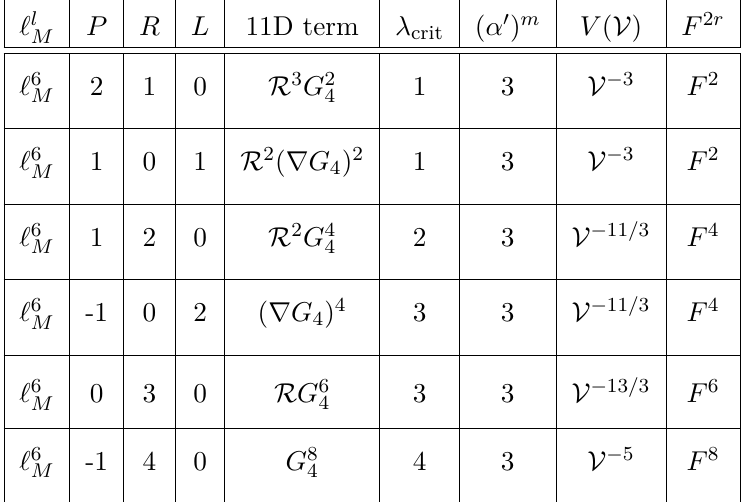
Table 4 . Summary of ( α 0 ) 3 corrections to the 4D potential at different F-term order from quantum reductions of M-theory compactified on trivially-fibred fourfolds. For convenience, we set x = o = 0 in λ because the volume behaviour in V ( V ) is independent on crit